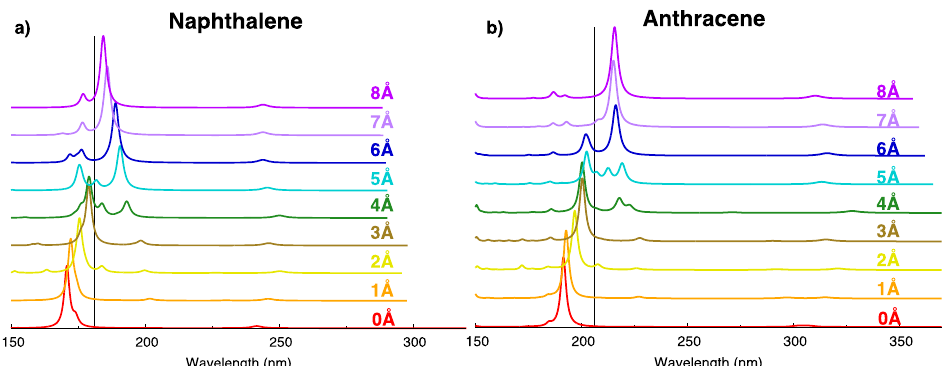
Figure 12. Comparison between vertical absorption spectra predicted for ( a ) naphthalene and ( b ) anthracene dimer, from TDA- ω B97X-D/6-31G* calculations. Modulation along the longitudinal shift from 0 Å to 8 Å. Different colors are used to plot spectra computed for different displacements. Black bar: absorption peak of the B b state of the monomer, calculated at TDA- ω B97X-D/6-31G* level.